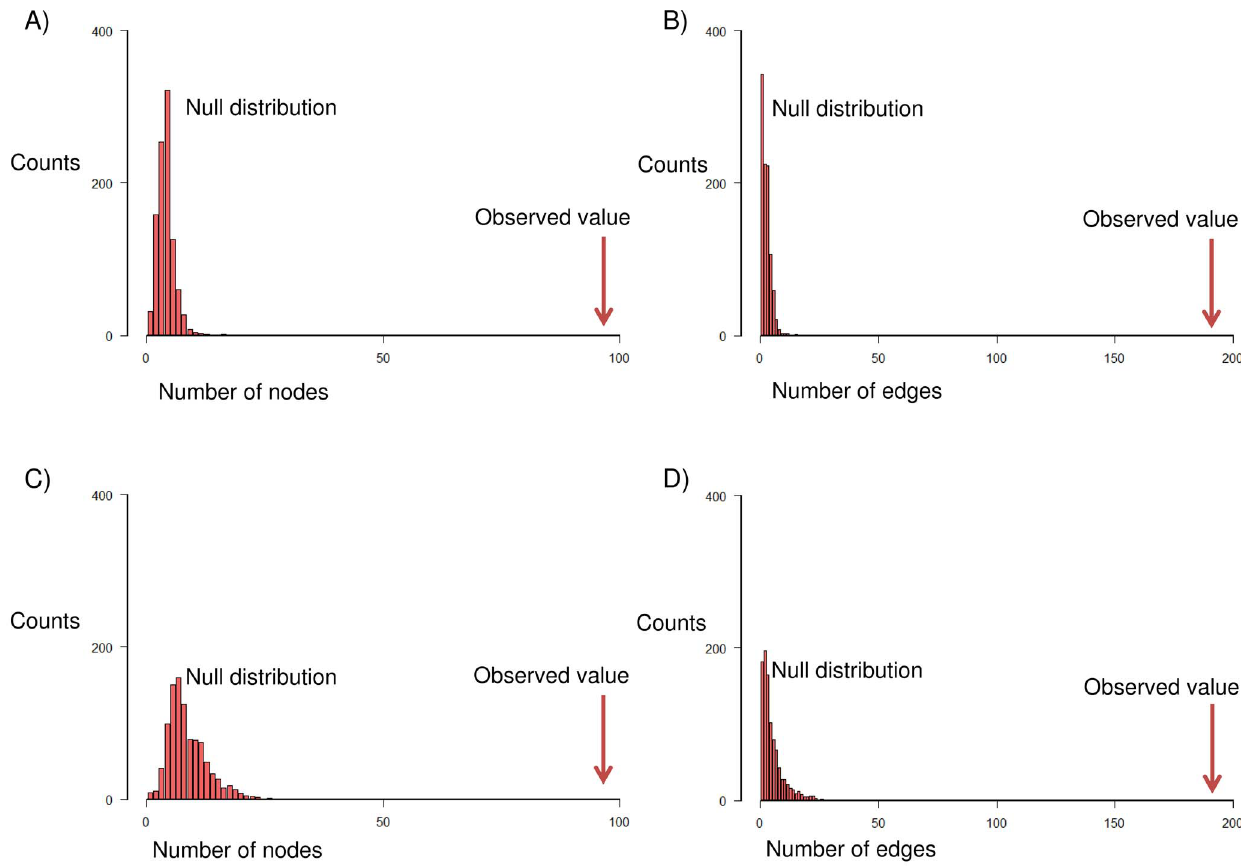
Figure 4. Statistical significance analysis of network module M5. A) The comparison of number of nodes in M5 to that from random sampling analysis. B) The comparison of number of edges in M5 to that from random sampling analysis. C) The comparison of number of nodes in M5 to the number present in shuffled protein-protein interaction (PPI) networks. D) The comparison of number of edges in M5 to the number present in shuffled PPI networks.